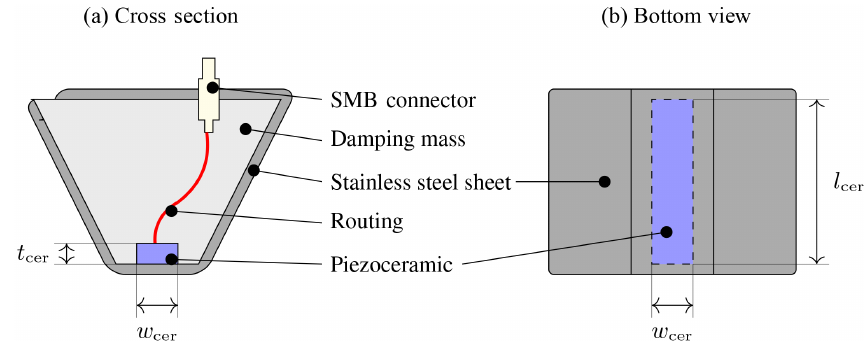
Figure 1. Cross section and bottom view of the purpose-build, piezoceramics-based transducer for the detection of plate